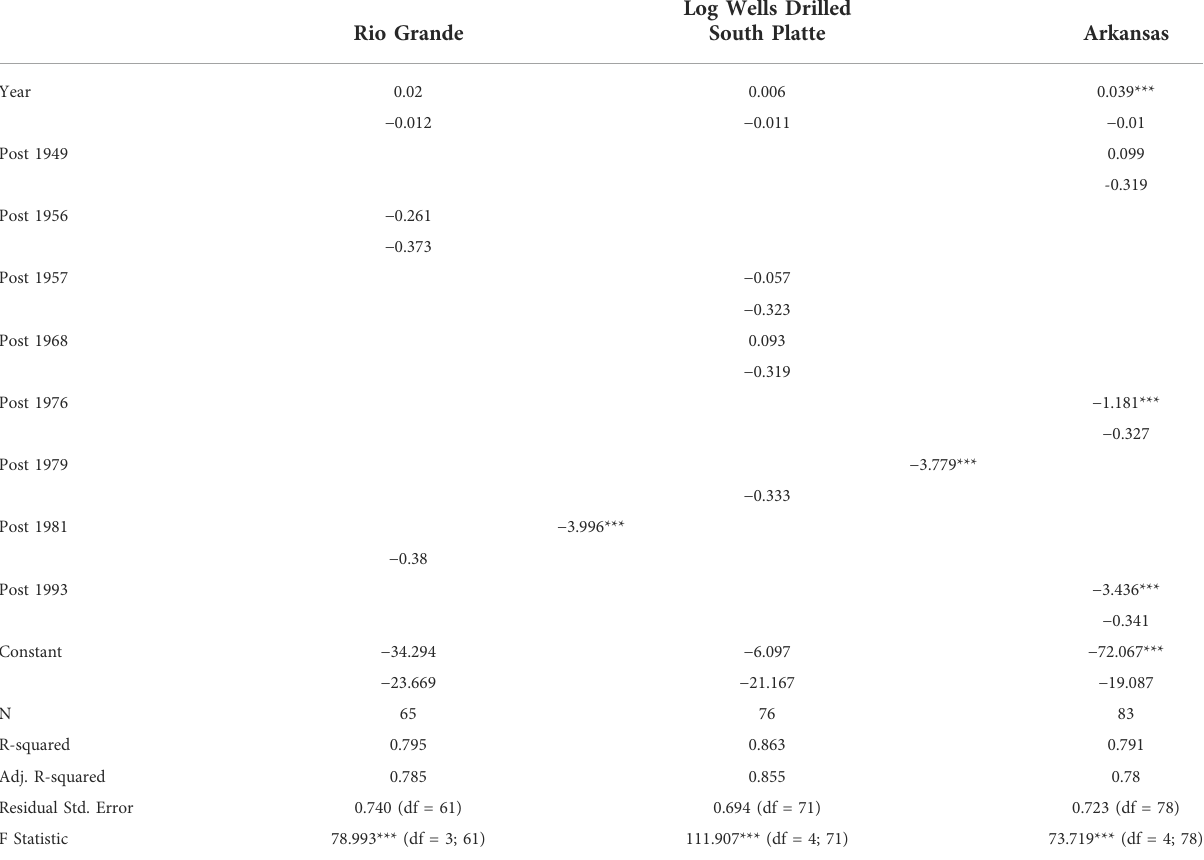
TABLE 2 Each post dummy is on or afterthe indicated year. Each break pointwas identi fi ed using the procedure of (Baiand Perron, 2003) minimizing BIC score. The control in each model is all years prior to the fi rst break